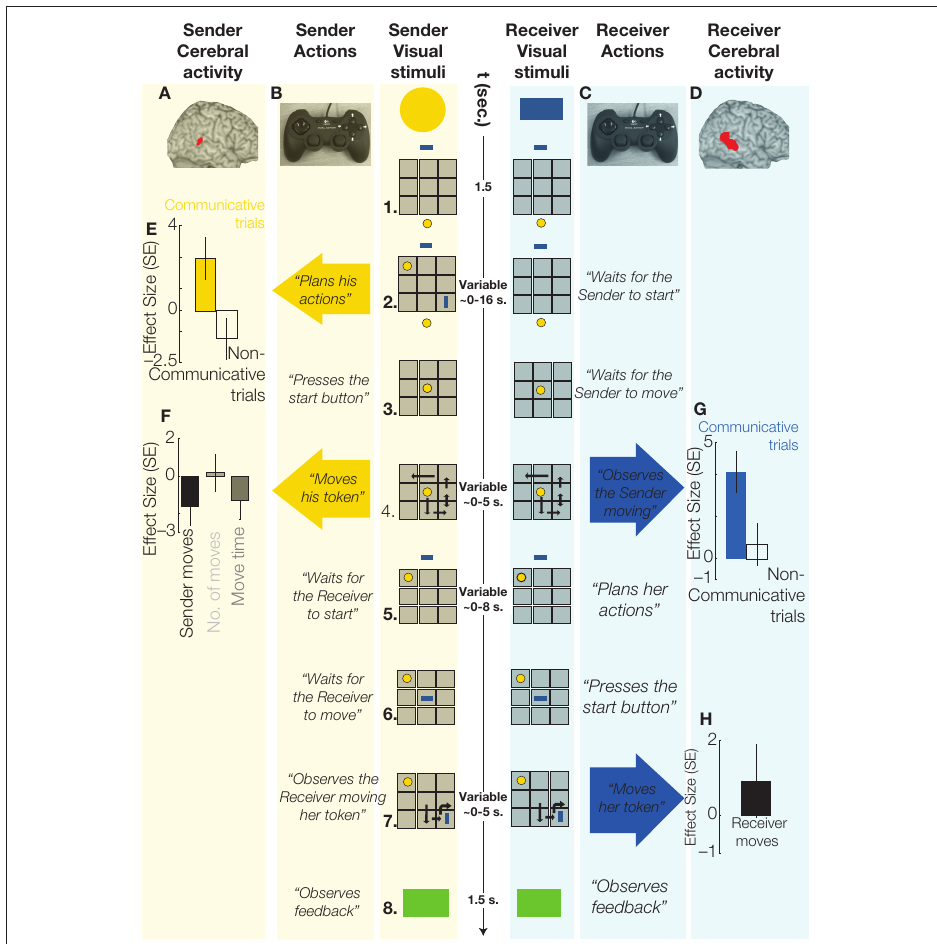
FIguRe 1 | Sequence of events in a communicative trial of the TCg, and cerebral activity evoked in the sender and in the receiver during relevant trial epochs. 1. Sender and receiver see a 3 × 3 game board (in gray) on separate screens, with their own tokens (yellow, blue) positioned below and above the board, respectively. 2. The goal configuration appears on the board. During communicative trials, the sender, but not the receiver, can see the goal configuration to be achieved at the end of the trial. The sender needs to share this information with the receiver, and he can do so only by moving his token over the board. Planning these communicative actions increased metabolic activity in the pSTS of the sender’s brain ( A , in red, MNI coordinates: 50, − 42, 14, p < 0.05 corrected for multiple comparisons), as compared to planning similar movements during non-communicative trials ( e ; effect size: parameter estimates of a multiple regression analysis in standard error [SE] units), i.e., trials in which both players could see the goal configuration. 3. When ready to move, the sender presses a start button and his token moves to the center of the board, being visible